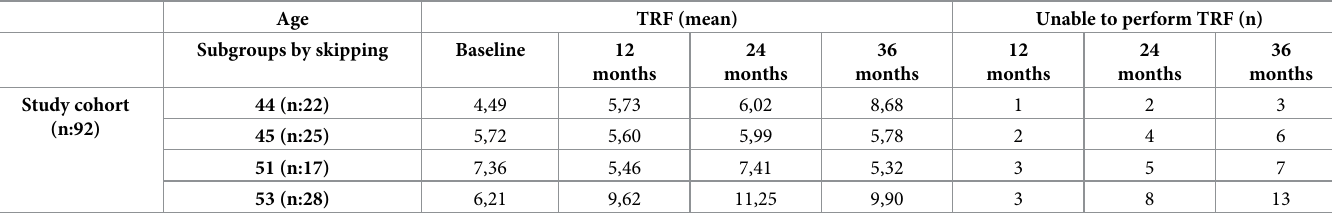
Table 2. Baseline 12, 24, 36 months TRF according to mutations amenable to skip exons 44, 45, 51 and 53. Age